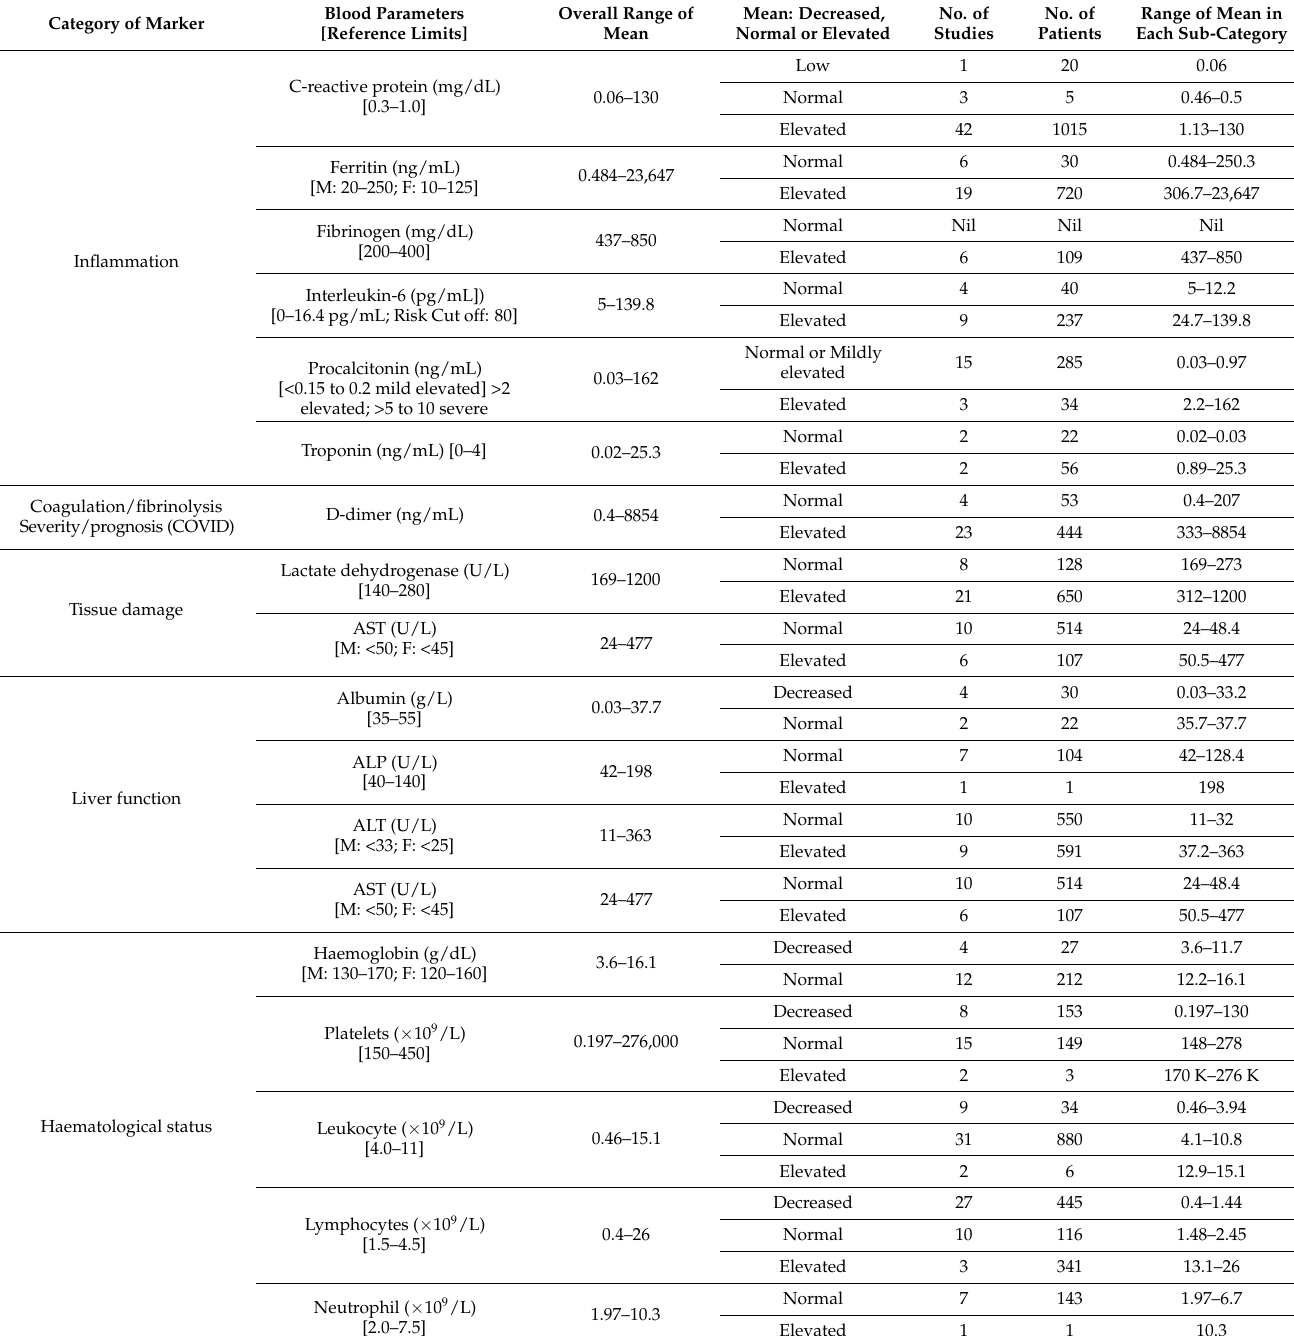
Table 3. Blood parameters among PLHIV co-infected with COVID-19.